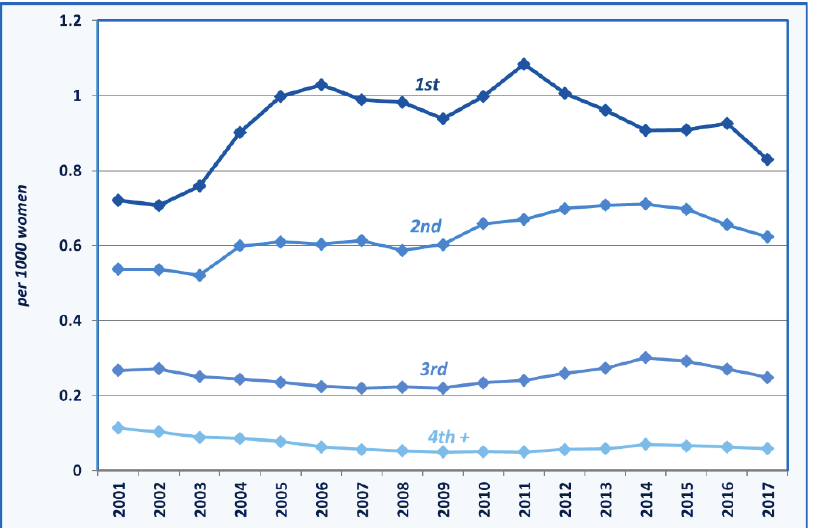
Figure 9. Dynamics of the total fertility rate by birth order, 2001-2017. Source: according to SSC data.